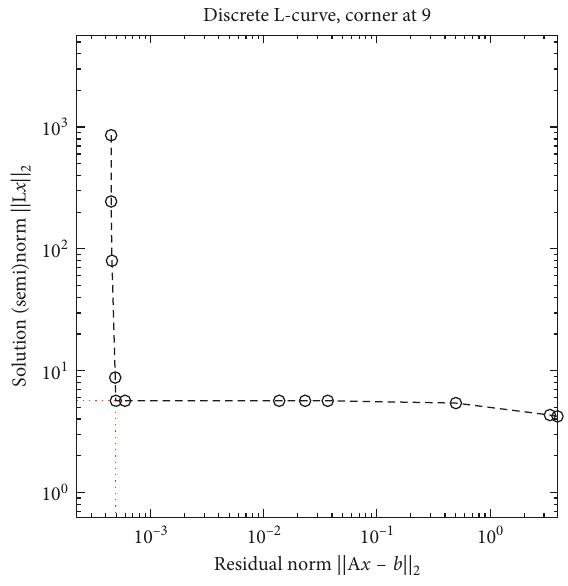
Figure 1: L-curve plot for a test